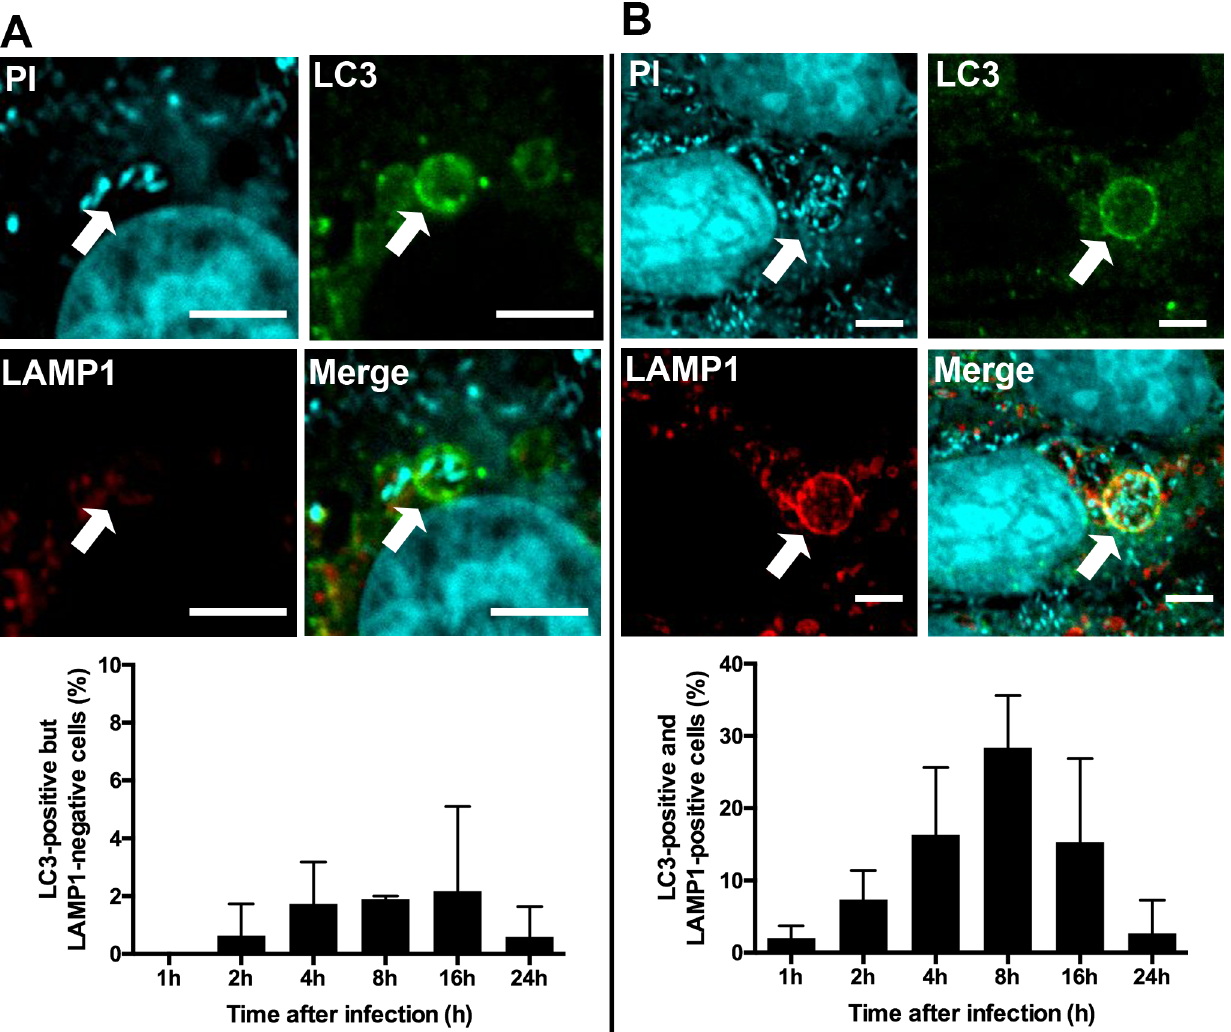
Fig 6. LAMP1 expression of LC3-positive P . acnes . Confocal images of P . acnes -infected MEF cells at 8 h MOI 1000 postinfection with fluorescent labeling of LC3 (green), LAMP1 (red), and P . acnes cells (cyan). (A) A small LC3-positive, but LAMP1-negative, vacuole containing P . acnes is indicated by an arrow, and the frequency of cells with such vacuoles is shown in the lower graph. (B) A large LC3-positive/ LAMP1-positive vacuole is indicated by an arrow, and the frequency of cells with such vacuoles is shown in the lower graph. Scale bar: 5 μ